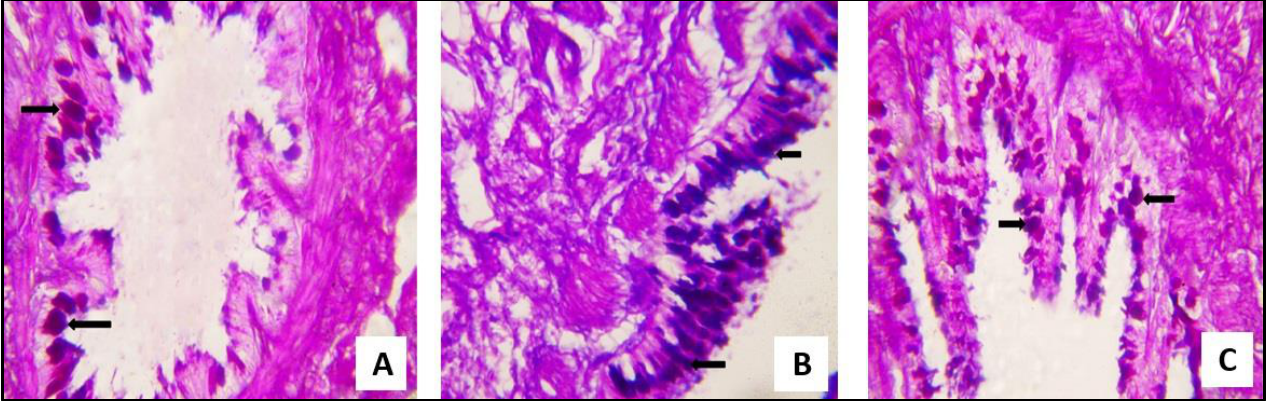
Figure 9. A section of rat lung showing the following features. ( A ) PAS-positive cells ( ↑ ) in the epithelium of a large bronchus of the control group (PAS stain, × 400). ( B ) An apparent increase in the PAS-positive cells in the bronchial passage lining epithelium of group II (PAS stain, × 400). ( C ) The PAS-positive cells in the lining epithelium of a large bronchial passage of group III is relatively comparable to the control group (PAS stain, ×